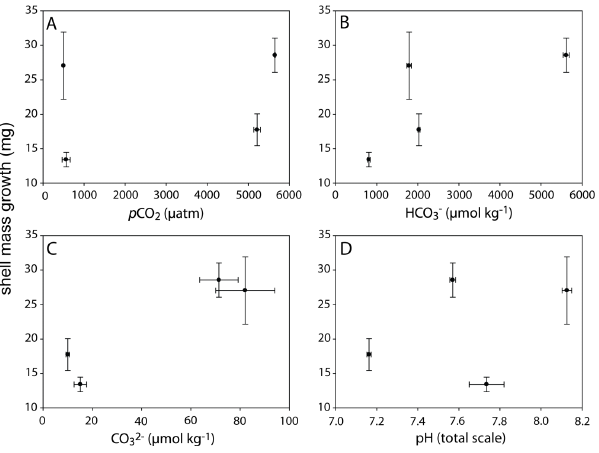
Figure 1. Exp. 1 Calcification response (measured as shell mass growth) of M. edulis juveniles kept under modified conditions for 15 days. Shell mass growth is plotted against seawater (a) p CO 2 , (b) [HCO − ], (c) [CO 2 − ] and (d) pH. Data represent mean ± SD. 3 3